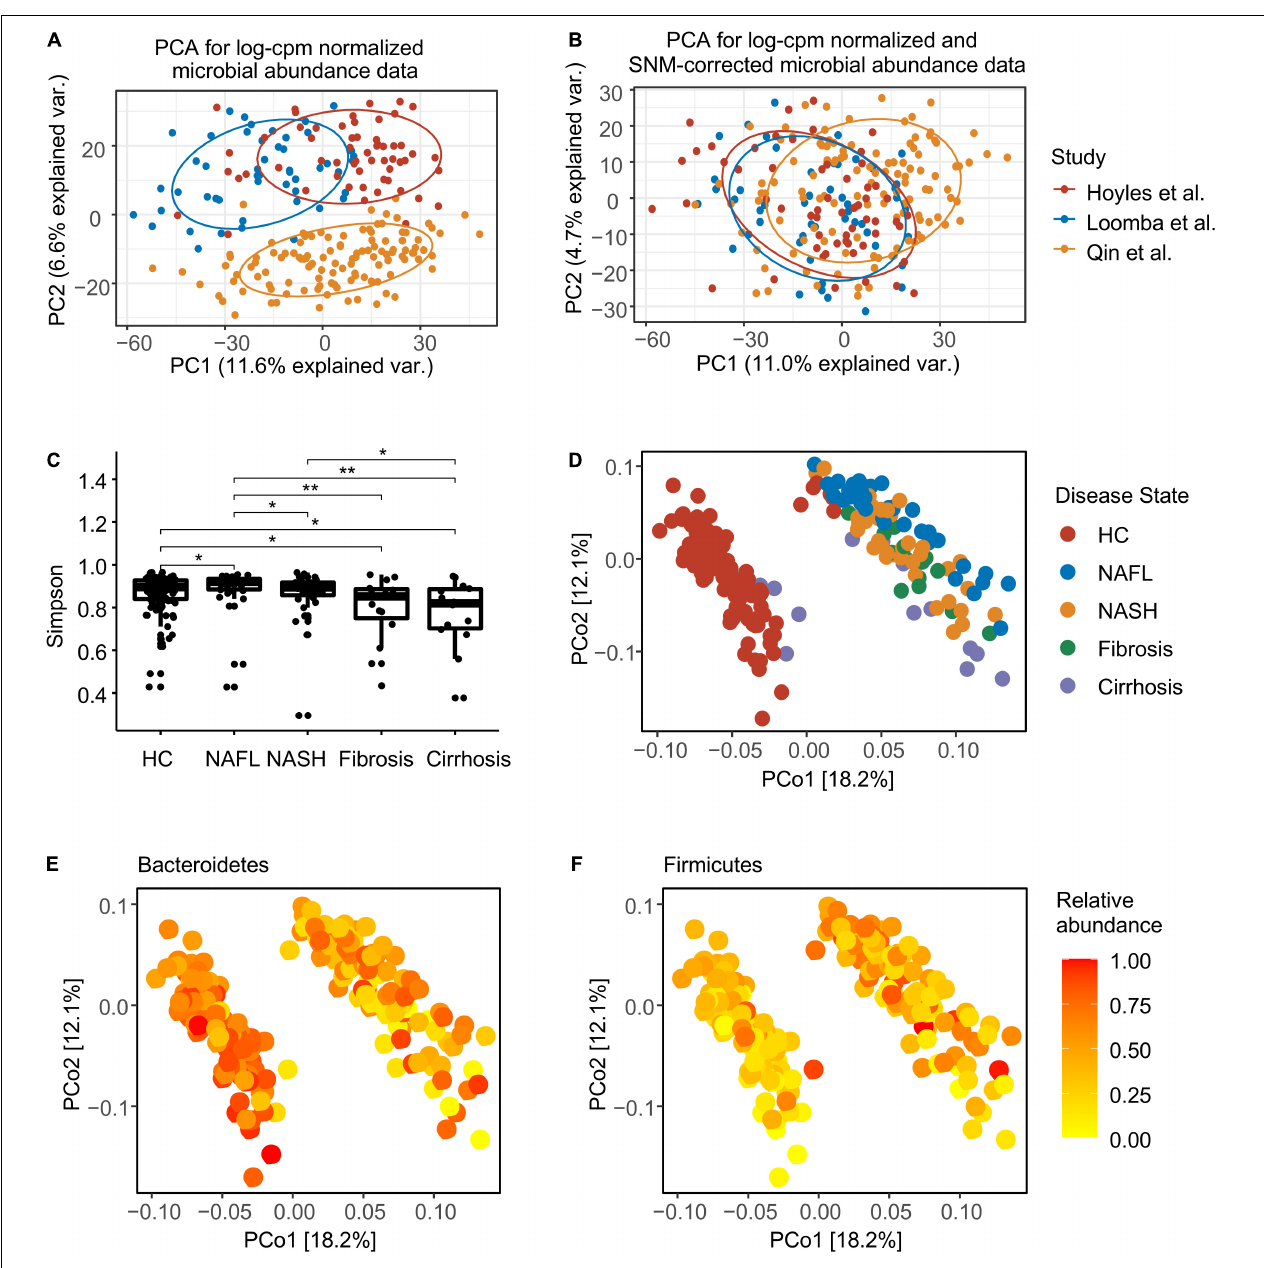
FIGURE 1 | Normalization and overview of the NAFLD microbiome taxonomic profiles at species level. (A) Principal components analysis (PCA) of log-cpm normalized data, with NAFLD microbiome samples colored by studies. (B) PCA of log-cpm-SNM data. (C) Alpha diversity for each disease stage. The differences were calculated by two-sided Wilcoxon test. * p < 0.05; ** p < 0.01. (D) Principal coordinates analysis (PCoA) based on species-level Bray–Curtis dissimilarity colored by disease stage. (E) PCoA colored by the normalized abundance of phylum Bacteroidetes. (F) PCoA colored by the normalized abundance of phylum Firmicutes. HC, healthy controls; NAFL, non-alcoholic fatty liver; NASH, non-alcoholic steatohepatitis.